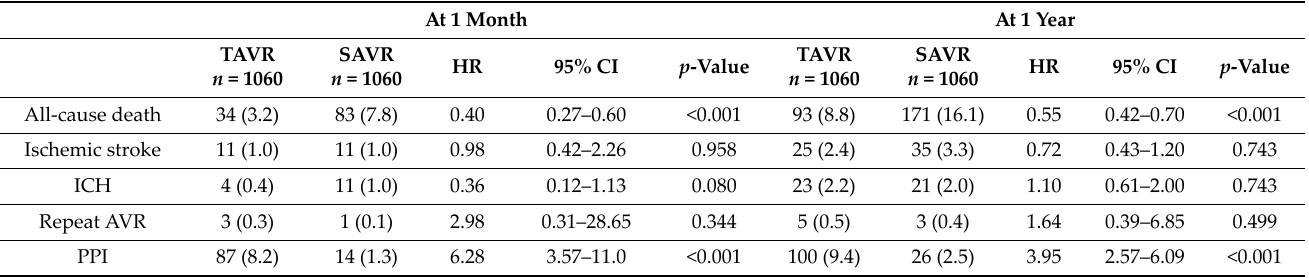
Table 2. Clinical events and safety outcomes in propensity‑score‑matched